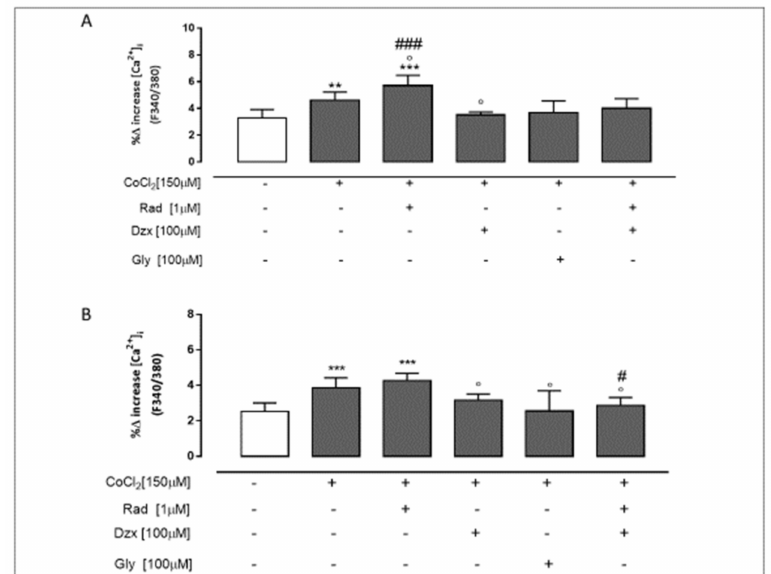
Figure 4. Mitochondrial Cx43 and the opening of mitochondrial K ATP channels prevent CoCl 2 - induced Ca 2+ homeostasis alteration. Cells were treated for 3 h with CoCl 2 (150 µ M); rad (1 µ M), dzx (100 µ M) and gly (100 µ M) were added 30 min before CoCl 2 administration. Panel ( A ) show the intracellular calcium content valued on H9c2 cells in calcium-free medium by means of ionomycin (1 µ M). Mitochondrial calcium pool was detected on H9c2 cells in calcium-free medium in